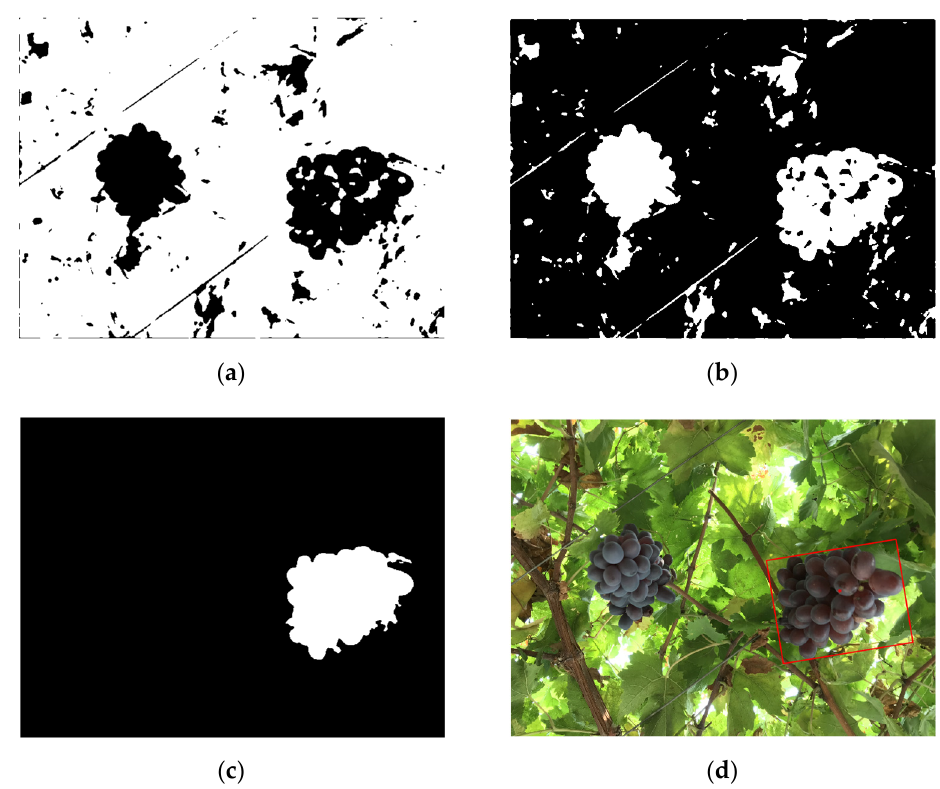
Figure 4. Recognition results. ( a ) Threshold segmentation. ( b ) Binary image. ( c ) Maximum connected domain. ( d ) Recognition results. (The red box is the outer rectangle of the target grape, and the red point is the center point of the outer rectangle).